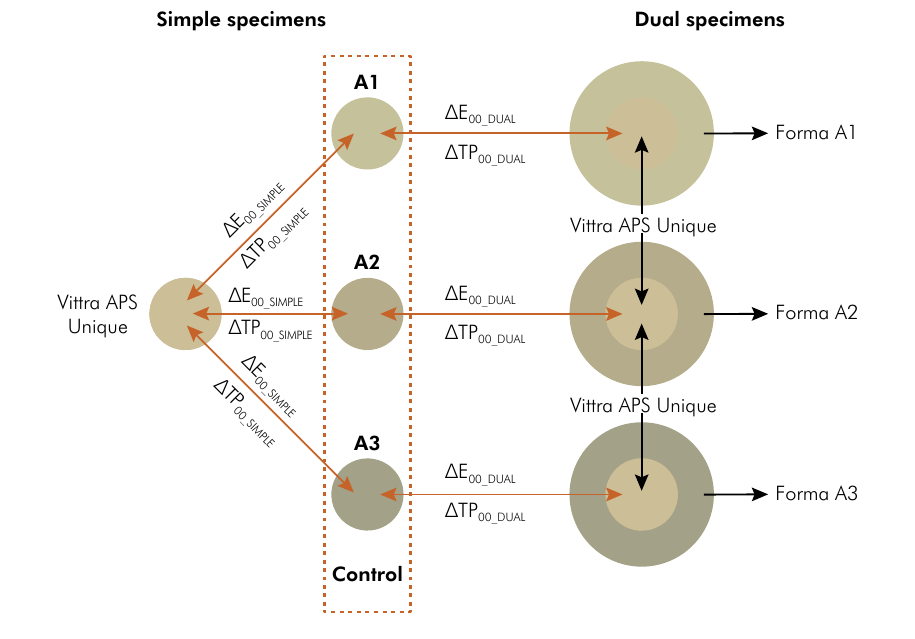
Figure 1. A schematic showing the specimen arrangement used to calculate color differences.